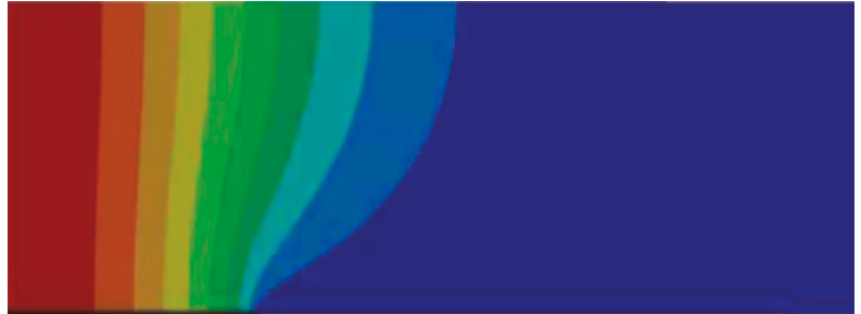
Figure 17. The sound pressure distribution when acoustic resonance occurs in reference result [16]. The dark blue and dark red regions in Figures 16 and 17 both are high sound pressure areas. The positive and negative sound pressure indicates the relative phase. The sound pressure amplitude above and below the plate is equivalent, and the phase difference is exact 180 degrees. When the onset of acoustic resonance is excited in the rectangular pipe model, the sound pressure distribution is presented in a way of the β mode in Parker resonance. The typical Parker resonance occurrence process is described well by the cal- culation method in this paper.